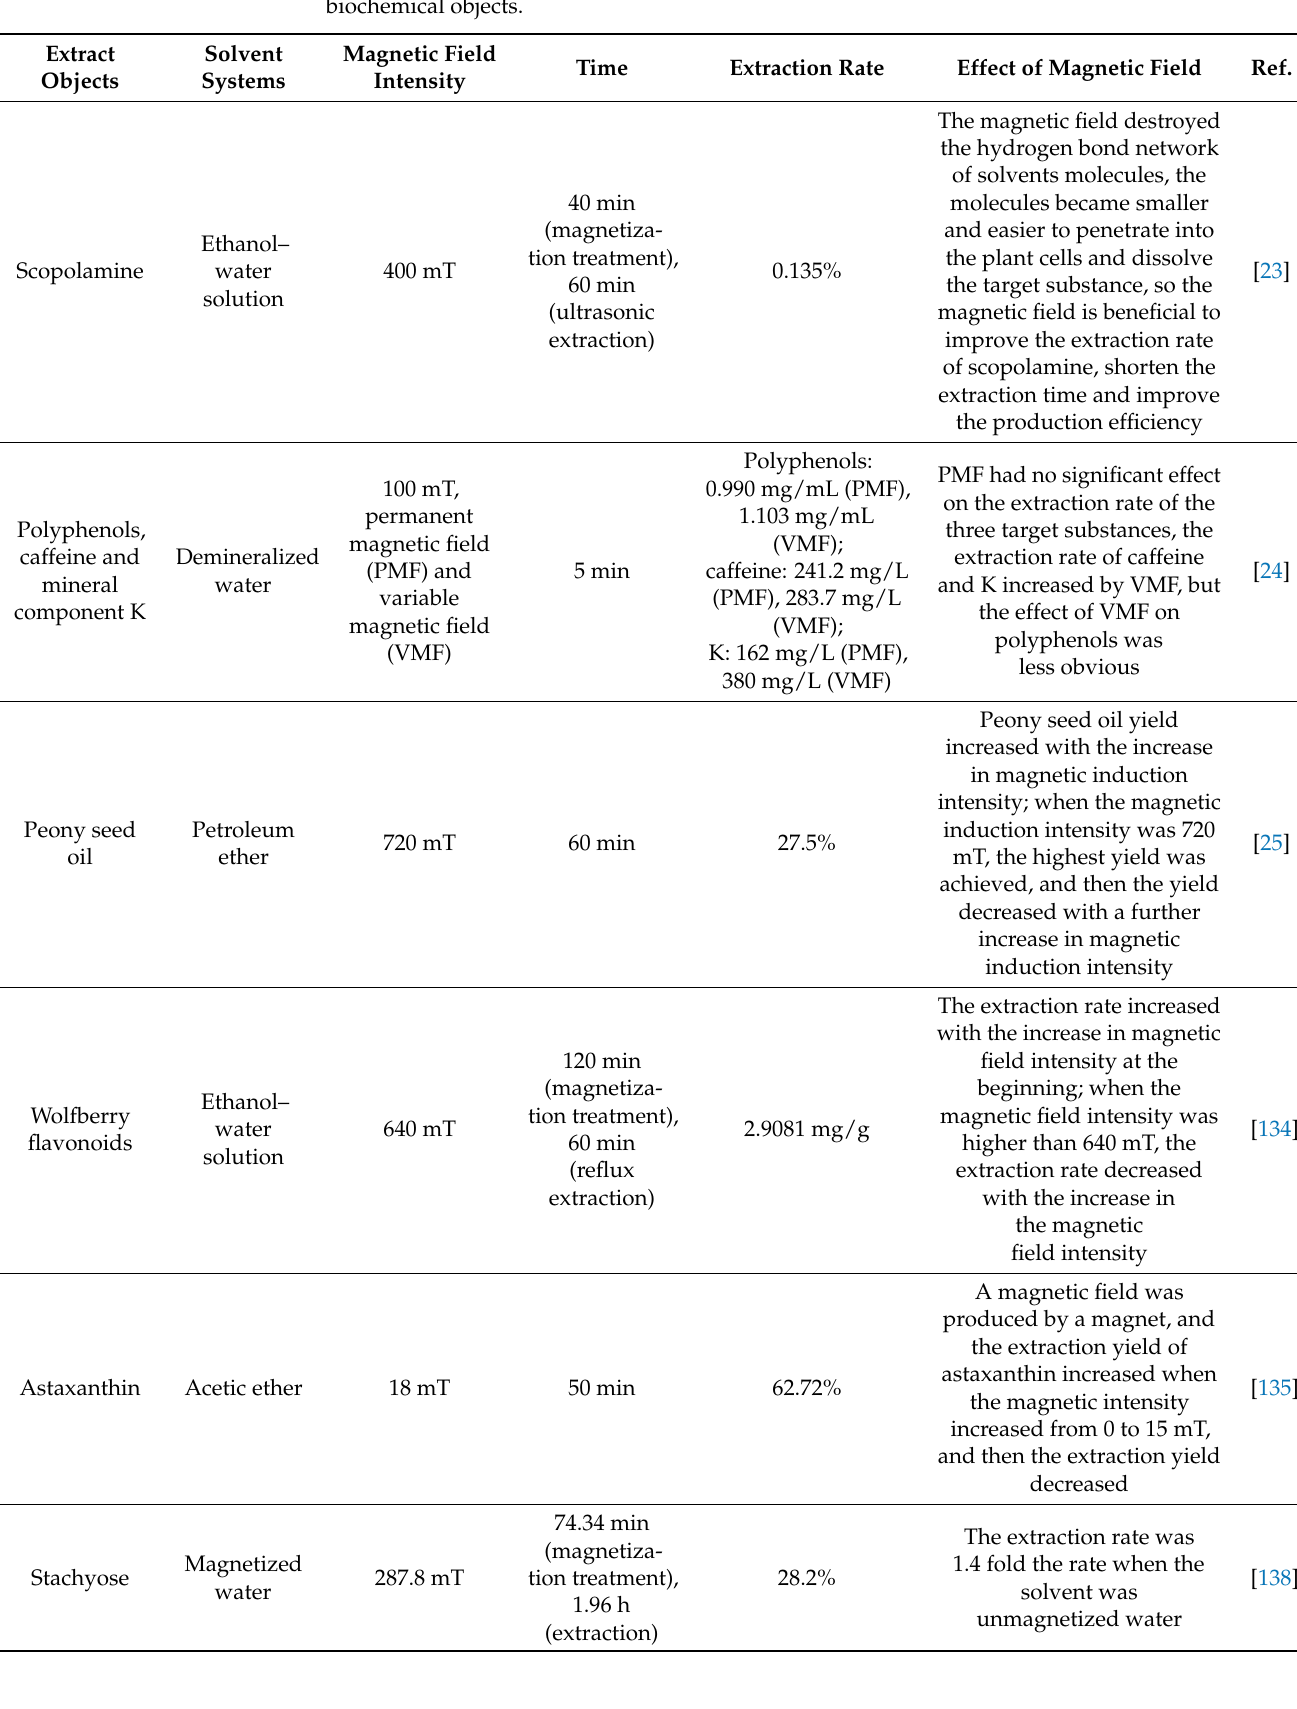
Table 5. Magnetic field in extraction and separation of bioactive molecules and together with biochemical